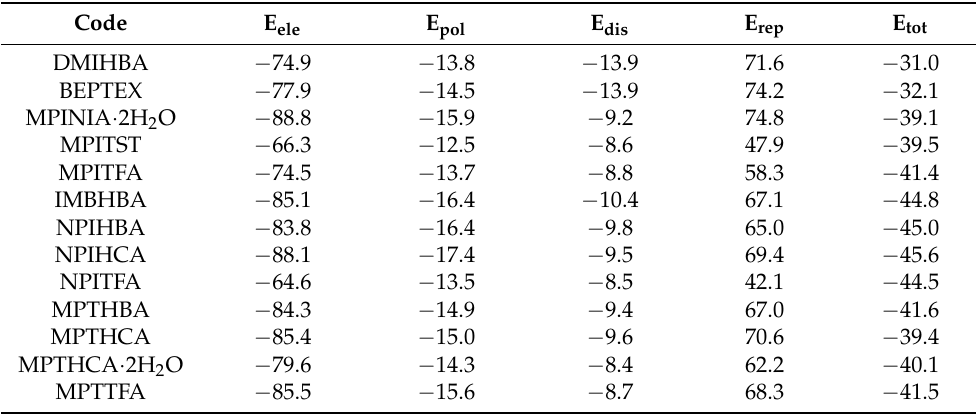
Table 3. Interaction energies (E tot ) in kJ mol − 1 calculated using B3LYP/6–31g (d,p). Code E